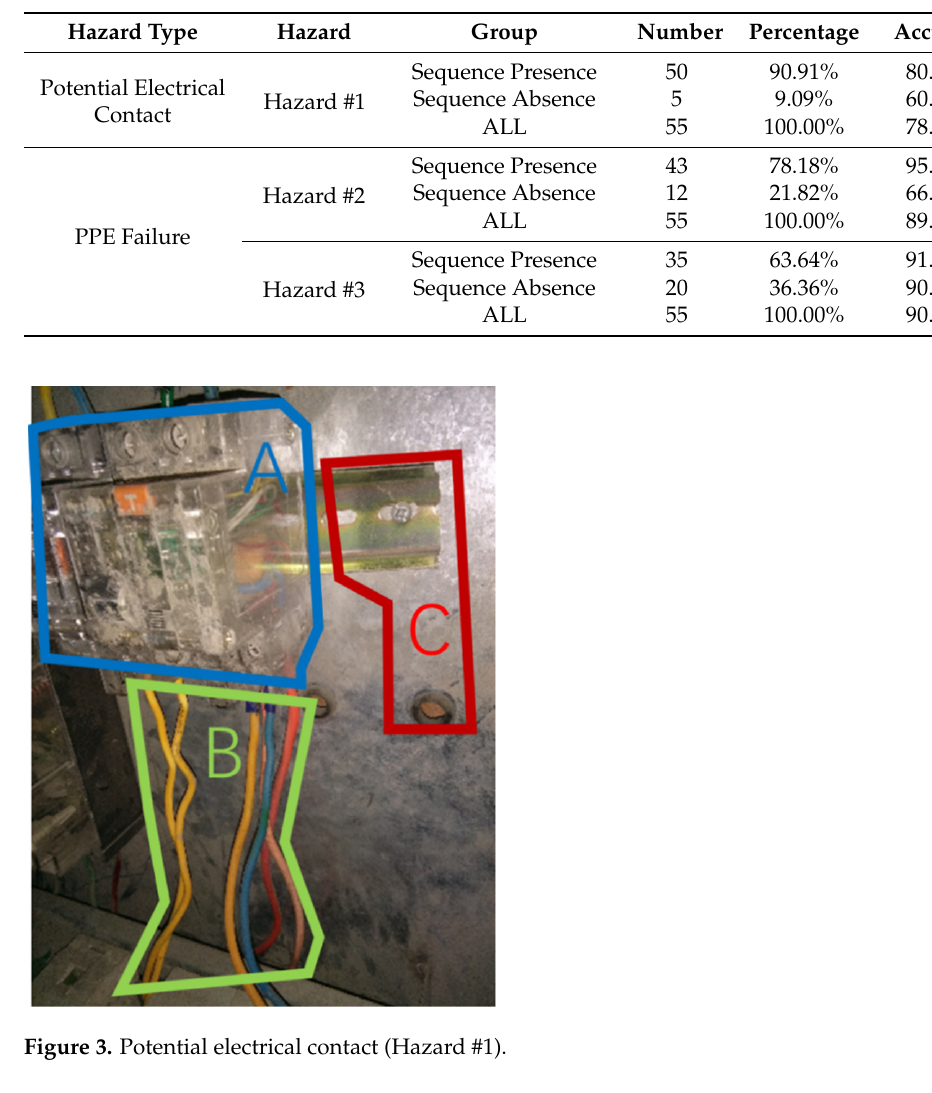
Table 1. Statistics of participants’ performance in the recognition of three hazards.